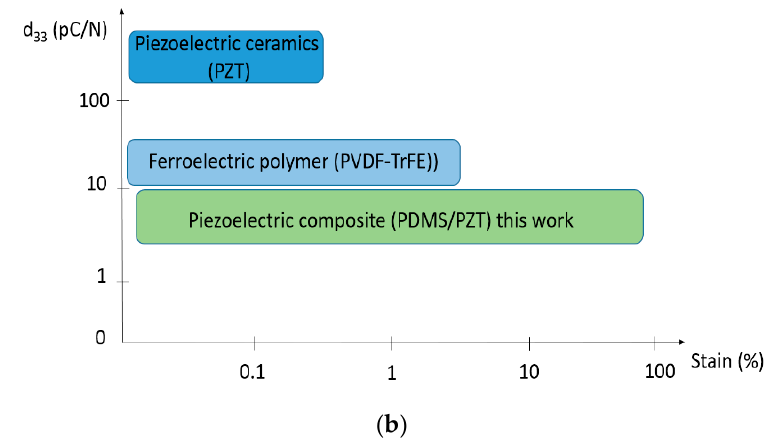
Figure 8. Overview of three typical piezoelectric materials (ceramic, polymer, composite) with their piezoelectric charge coefficient: ( a ) versus temperature, and ( b ) versus mechanical strain.